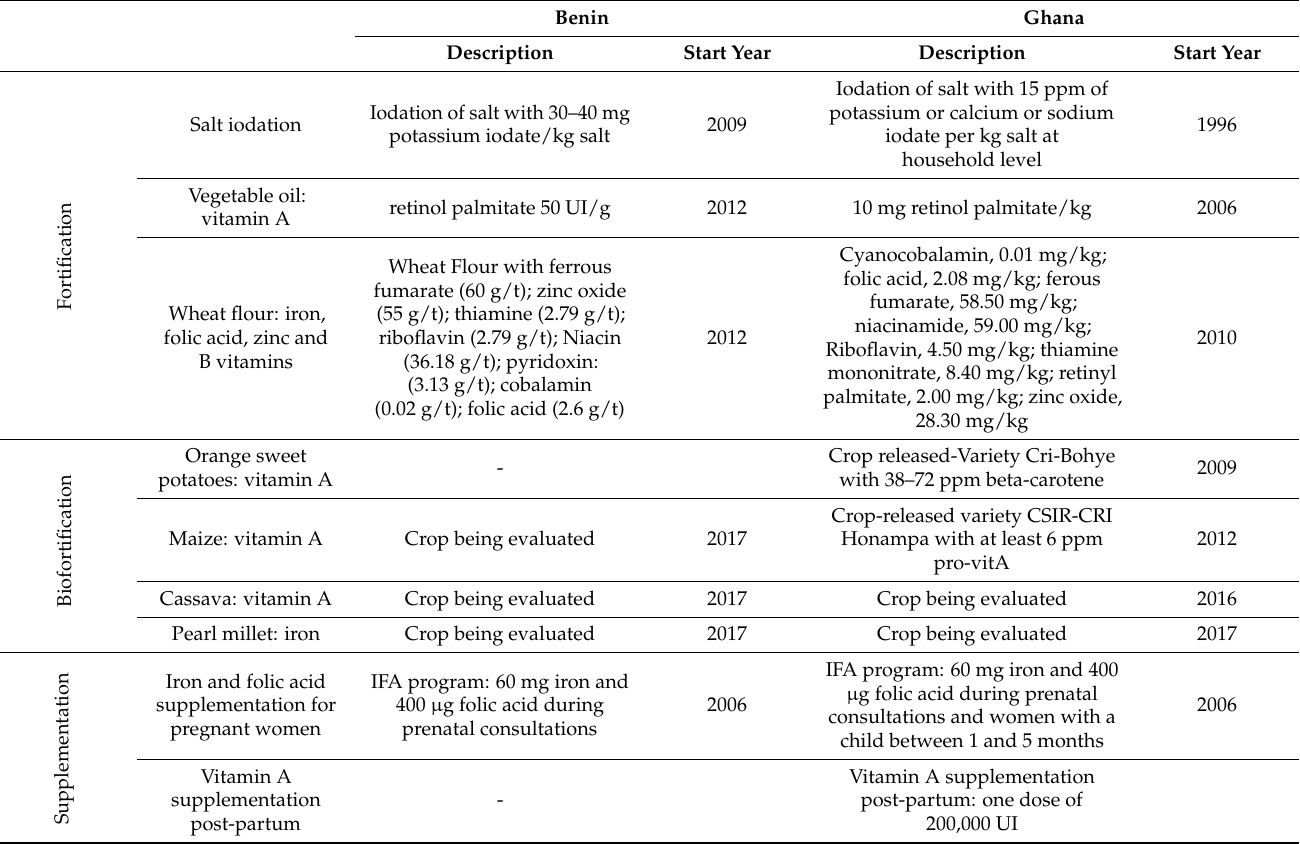
Table 2. Mandatory micronutrient interventions for women in Benin and